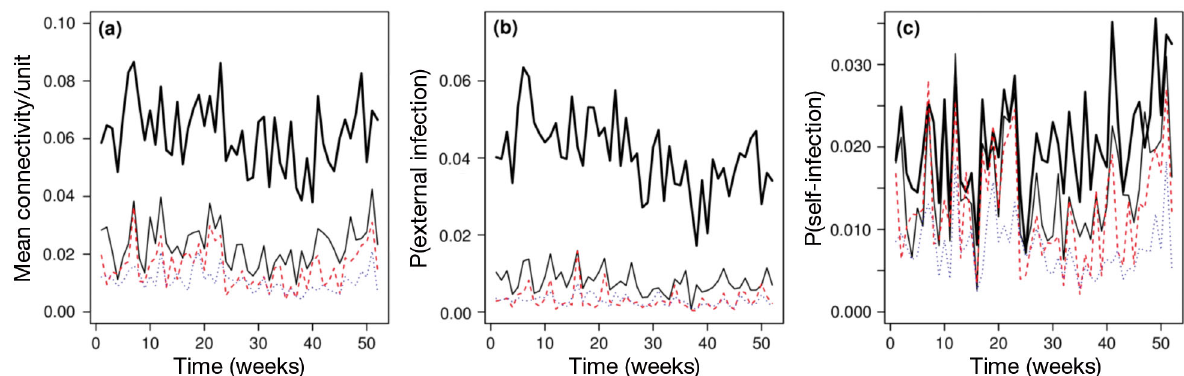
Fig. 5. Comparing sites and management units over time. Each graph shows sites (thick black line), Farm Management Areas (FMAs; thin black line), Disease Management Areas (DMAs; dashed red line) and Fish Health Management Reporting Areas (FHMRAs; dotted blue line). (a) Mean connectivity per management unit over time (sum of connectivity matrix, divided by number of sites or units). (b) Mean probability of external infection over time (that is, between sites or units: mean connectivity minus self-infection). (c) Mean probability of self-infection of sites/units over